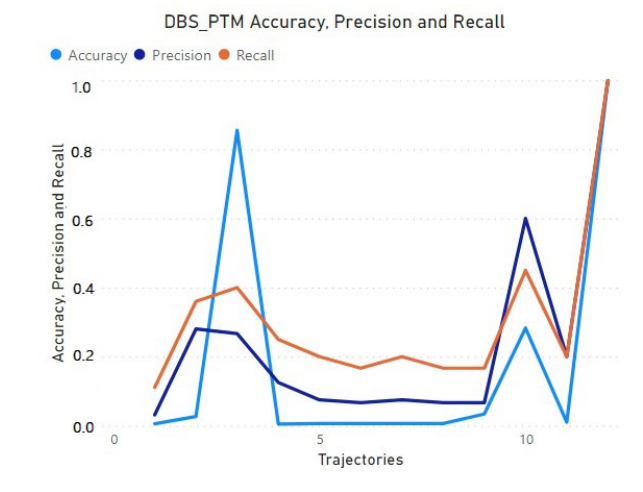
Figure 10. DBSCAN performance for the PTM dataset: precision, recall, and accuracy.